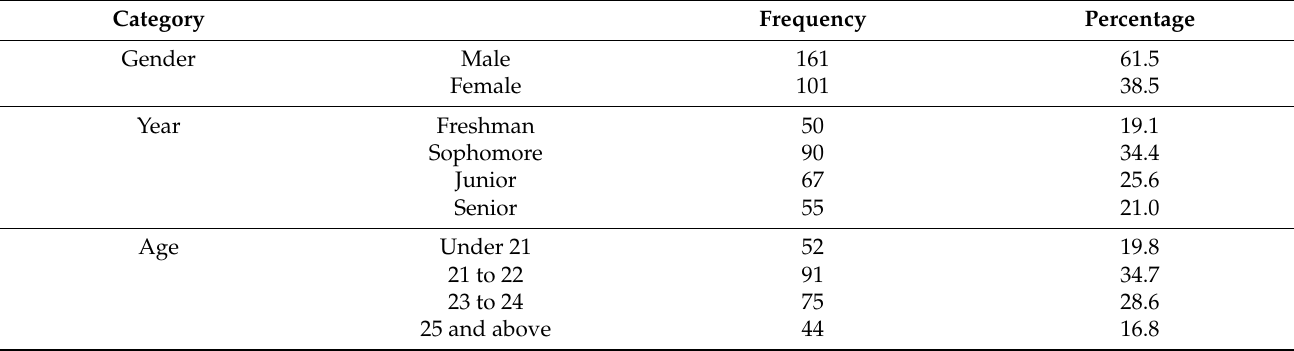
Table 2. General characteristics of subjects.